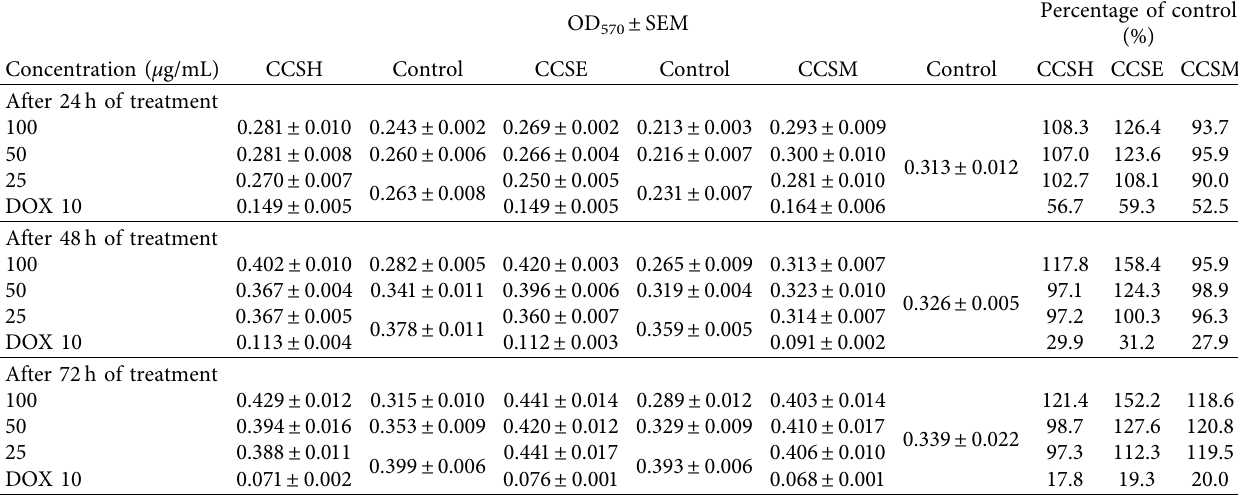
Table 2: The cytotoxicity using HepG2 of extracts of Cleome viscosa . OD 570 ± SEM